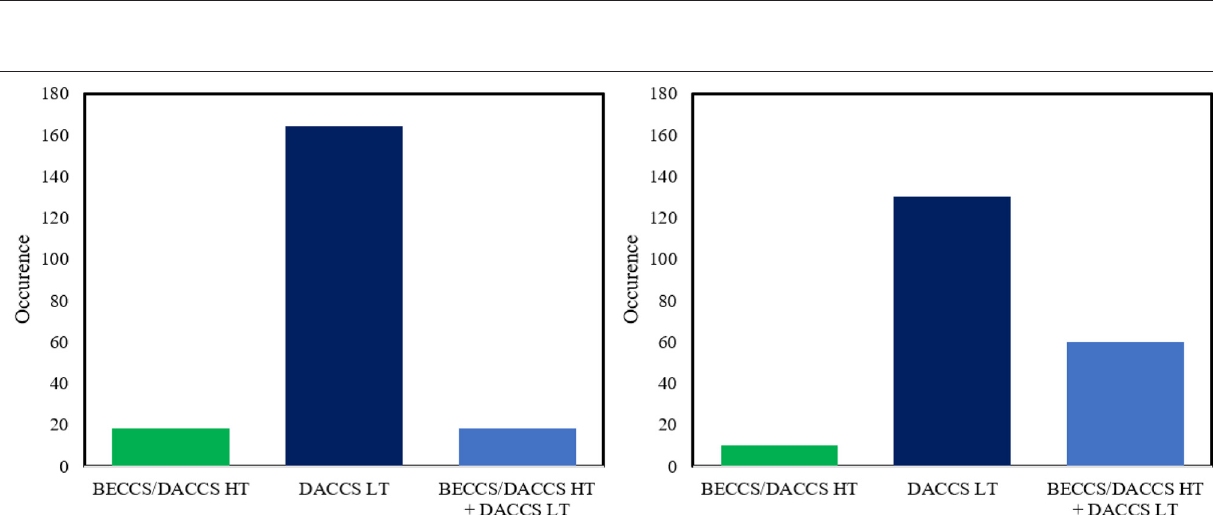
Direct Air Carbon Capture and Storage (DACCS) are two